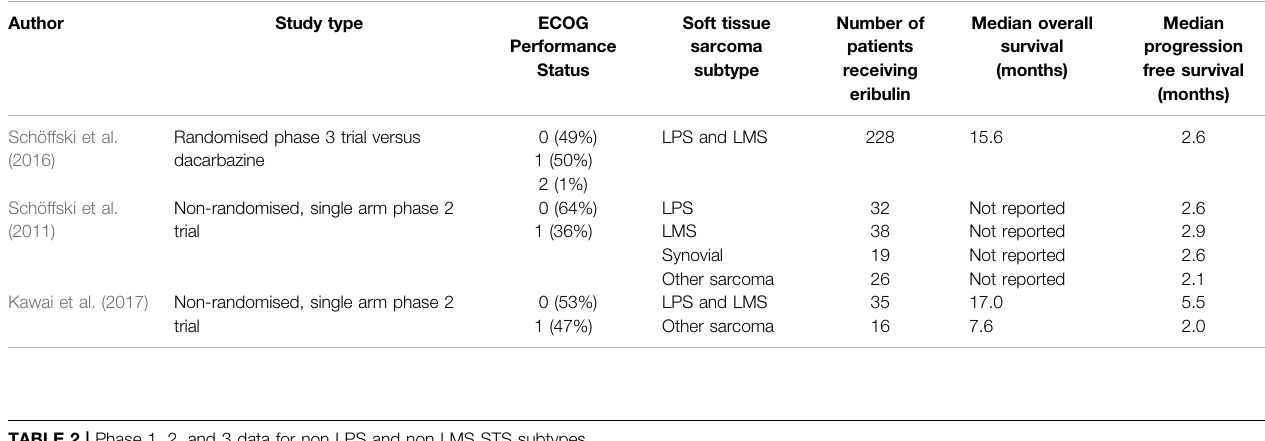
TABLE 2 | Phase 1, 2, and 3 data for non LPS and non LMS STS